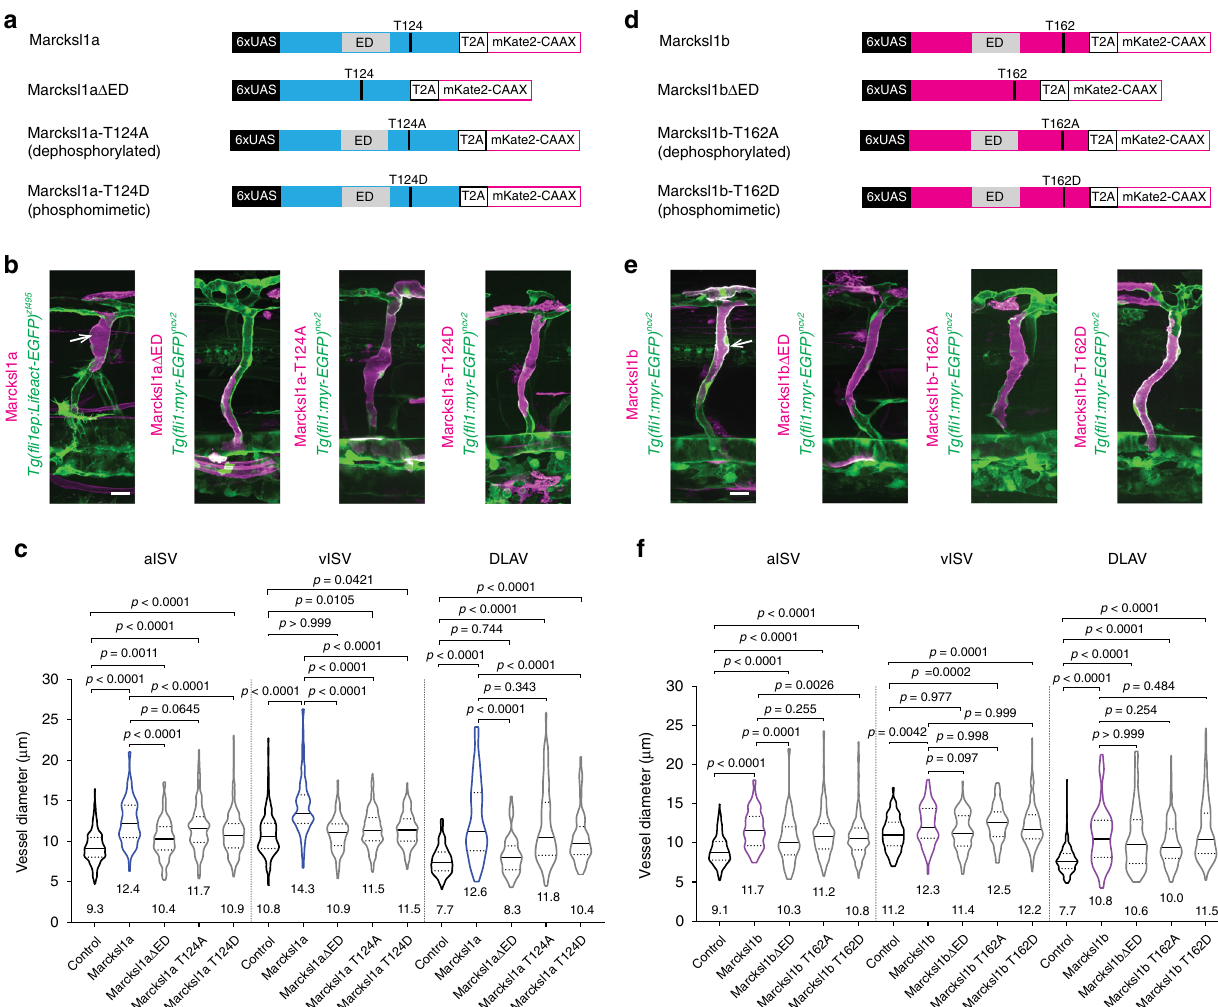
Fig. 2 Elevated Marcksl1 expression level increases blood vessel diameter. a , d Plasmid constructs encoding GAL4FF/ UAS -driven expression of wildtype or mutated Marcksl1a ( a ) and Marcksl1b ( d ) proteins trailed by a self-cleaving T2A peptide fused to mKate2-CAAX. b , e Maximum intensity projection of confocal z-stacks of ISVs of 2 dpf Tg( fl i1:GAL4FF) ubs3 ;Tg( fl i1ep:Lifeact-EGFP) zf495 or Tg( fl i1:GAL4FF) ubs3 ;Tg( fl i1:myr-EGFP) ncv2 embryos expressing constructs encoding wildtype or mutated Marcksl1a ( b ) and Marcksl1b ( e ). Marcksl1 overexpressing cells are in magenta (cells expressing mKate2-CAAX). Arrows indicate dilated vessel. c Quanti fi cation of aISV, vISV and DLAV diameter in control and Marcksl1a-overexpressing blood vessels (control: n = 60 aISVs/51 vISVs/54 DLAVs from 85 embryos; wildtype Marcksl1a: n = 17 aISVs/16 vISVs/16 DLAVs from 25 embryos; Marcksl1a Δ ED: n = 16 aISVs/20 vISVs/16 DLAVs from 24 embryos; Marcksl1a-T124A: n = 43 aISVs/44 vISVs/35 DLAVs from 33 embryos; Marcksl1a-T124D: n = 43 aISVs/32 vISVs/24 DLAVs from 29 embryos). f Quanti fi cation of aISV, vISV and DLAV diameter in control and Marcksl1b-overexpressing vessels (control: n = 62 aISVs/35 vISVs/67 DLAVs from 47 embryos; wildtype Marcksl1b: n = 23 aISVs/14 vISVs/20 DLAVs from 24 embryos; Marcksl1b Δ ED: n = 21 aISVs/22 vISVs/25 DLAVs from 23 embryos; Marcksl1b-T162A: n = 31 aISVs/15 vISVs/22 DLAVs from 21 embryos; Marcksl1b-T162D: n = 54 aISVs/42 vISVs/34 DLAVs from 34 embryos). Violin plots represent the entire range of values, dotted lines indicate fi rst and third quartiles, center lines are median. Mean values are indicated. Data are collected from 2 (Marcksl1b Δ ED), 3 (Marcksl1a-T124A, Marcksl1a-T124D, Marcksl1b-T162A and Marcksl1b-T162D) and 4 (Marcksl1a Δ ED, wildtype Marcksl1a and Marcksl1b) independent experiments and analyzed by ordinary one-way ANOVA with Sidak ’ s multiple comparisons test. ED effector domain; DLAV dorsal longitudinal anastomotic vessel; ISV intersegmental vessel; aISV arterial ISV; vISV venous ISV. Scale bars, 20 µ m. Source data are provided as a Source data fi